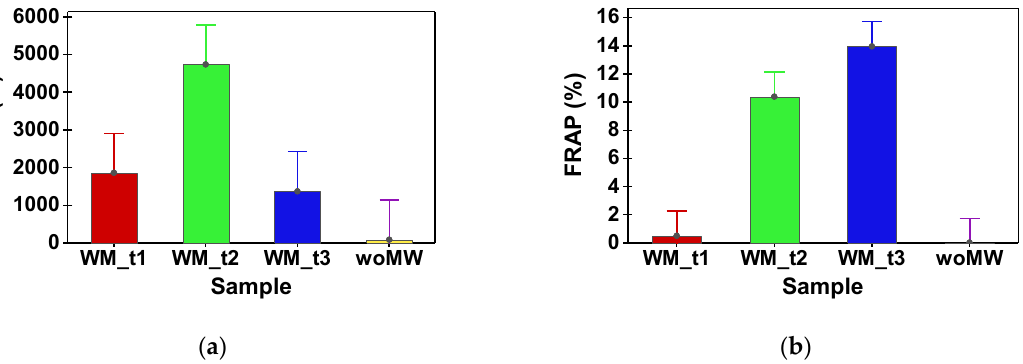
Figure 4. Ratios (%) between peppermint samples (MW_t1, MW_t2, and MW_t3) and the untreated sample, woMW. ( a ) Antioxidant capacity using DPPH assay. ( b ) Antioxidant capacity using FRAP assay. The highest level of total phenols and flavonoids were obtained in the sample